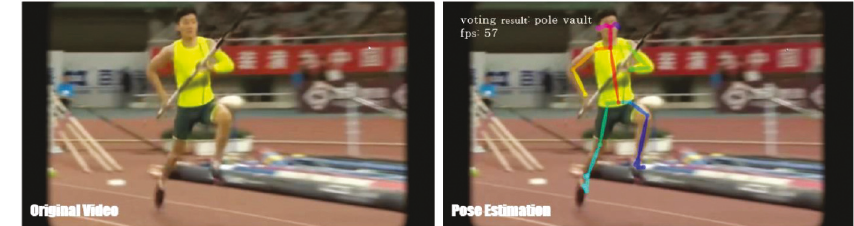
Figure 6: Results of human pose estimation based on AAEN for pole vault category track and field events.